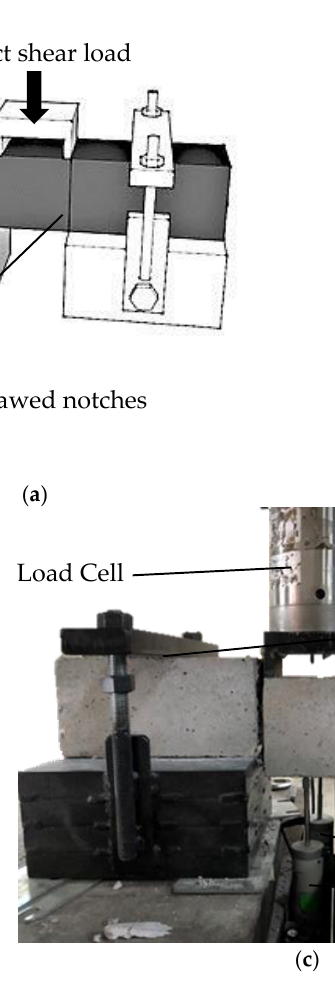
Figure 2 . Photos illustrating and displaying the ( a ) test set-up according to the JSCE-G 533-1999 test standard, ( b ) notches sawed to pre-define crack propagation, and ( c ) direct shear testing of the specimens.